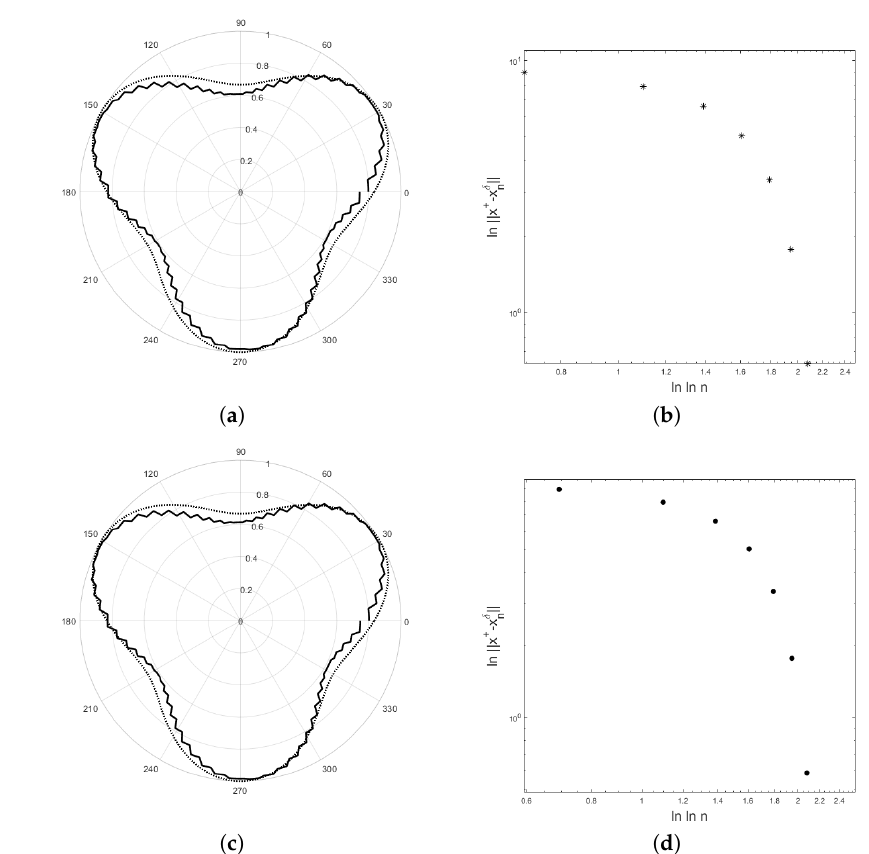
Figure 5. The polar plot shows the exact solution (dot line) and the computed solution (solid line) for ( a ) i max = 3 and ( c ) i max = 6 with δ = 0.001. The error of iteration step using a double logarithm scale for ( b ) i max = 3 and ( d ) i max = 6 are shown. The initial value is x 0 = 0.1 + 1 sin ( 3 s ) . The parameter α n in Equation (71) is 1 5